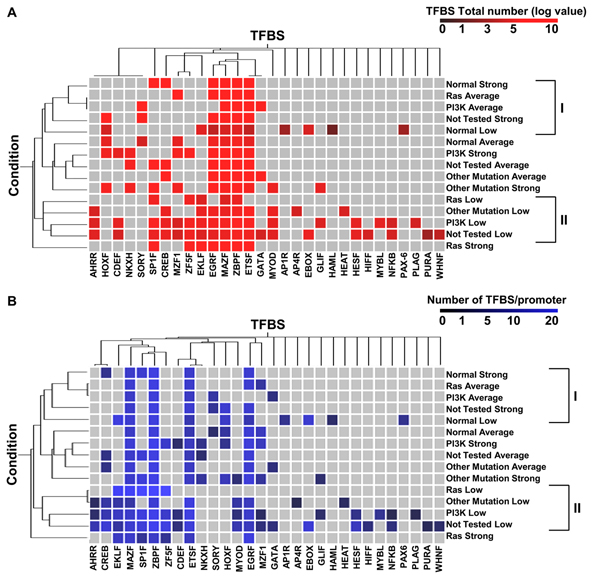
Hierarchical clustering of TFBSs present in the promoters of the 41 PKA pathway-encoding genes, according to total number and frequency. Two-way (TBFS, column and expression subgroup, see Figure 3, row) hierarchical clustering of the TFBS present within the promoters of the 41 PKA pathway-encoding genes. Clustering was run according to the total number of TBFS present in each group (panel A) or to the frequency, i.e. the total number of a given TBFS divided by the number of promoters (panel (B). The color-coding scale is shown at the top of each panel. The distance function is based on Pearson correlation and complete linkage clustering. The two classes, corresponding to the main arms of the dendrogram, derived from clustering according to "Condition" are shown on the right of each dendrogram.